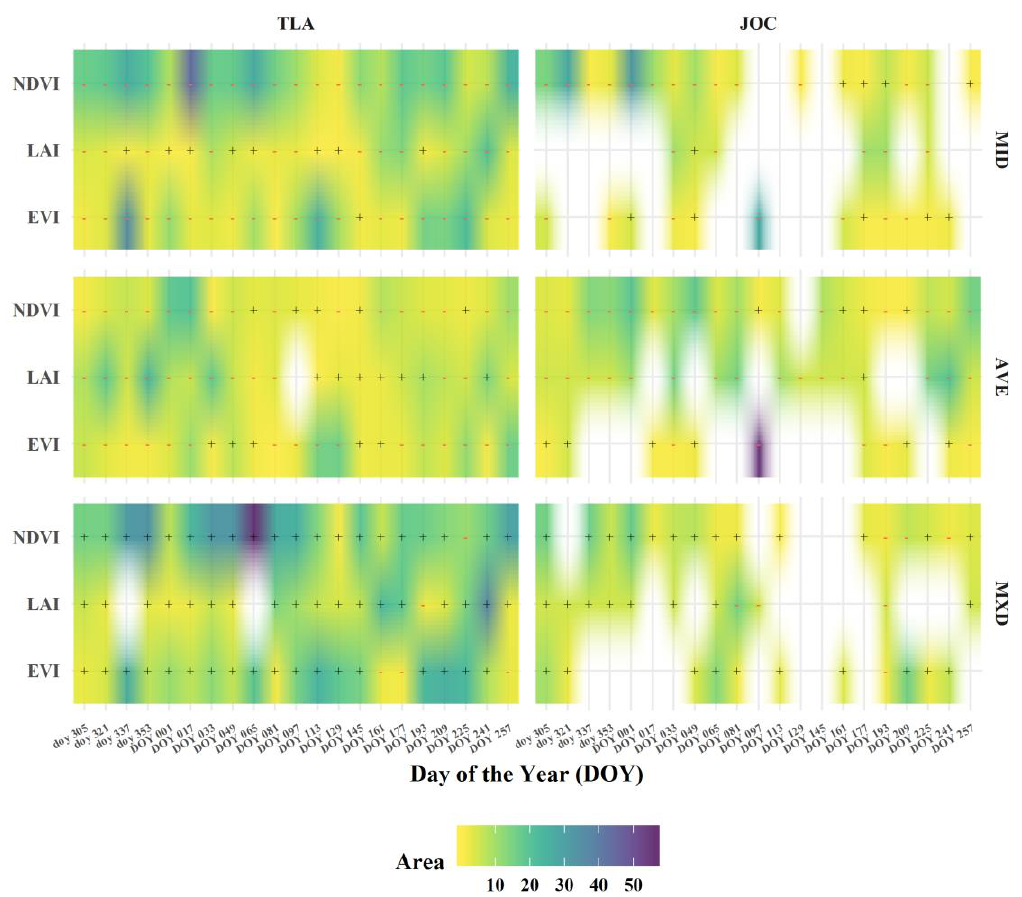
Figure 7. Temporal associations between density values (Minimum earlywood density—MID, average density—AVE, and maximum latewood density—MXD) with remotely sensed variables derived from MODIS (Normalized Difference Vegetation Index—NDVI, Leaf Area Index—LAI, and Enhanced Vegetation Index—EVI) in two high-elevation forests in central Mexico (Tláloc—TLA and Jocotitlán—JOC). The color ramp represents the area covered by a significant correlation while the symbols (negative in red and positive in black) describe the slope of the correlation. Day of previous year are indicated with in lowercase (doy) and in uppercase for the current years. Note the relevance of DOY065 and DOY097 for TLA and JOC, regarding MXD and AVE, respectively.